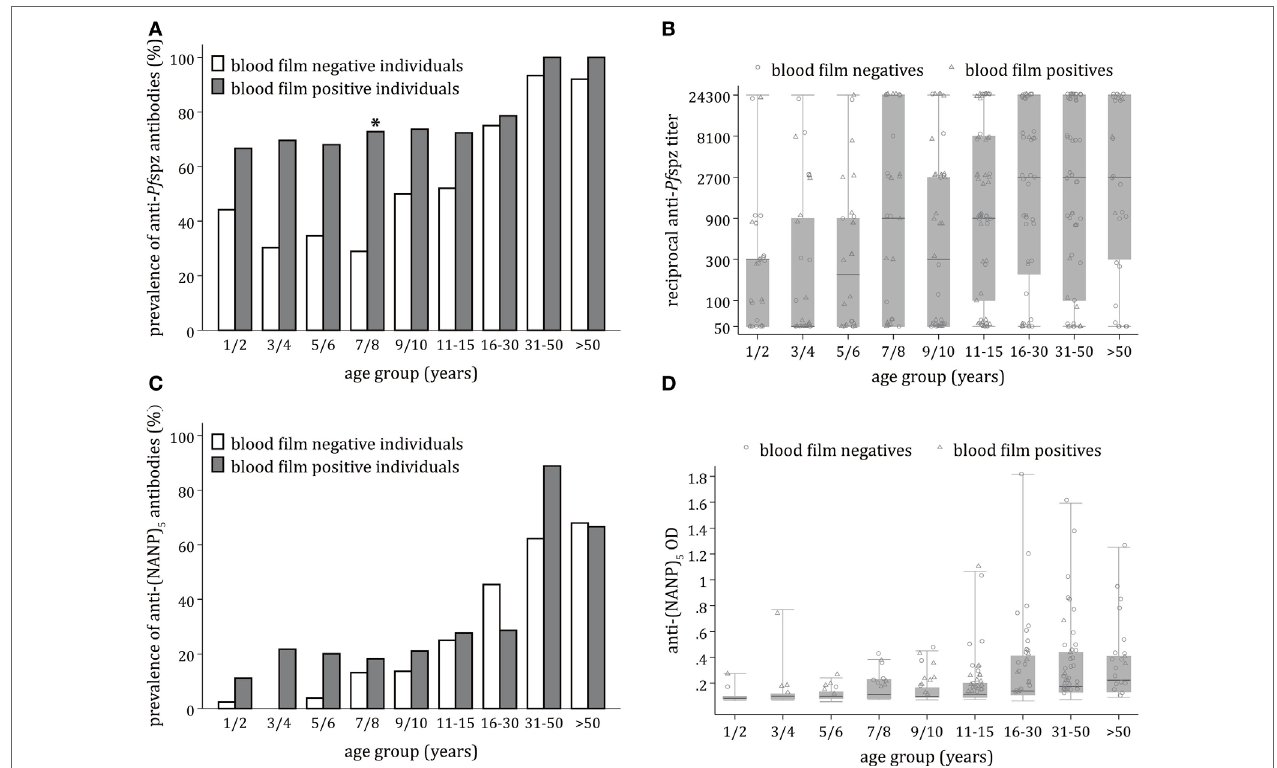
FigUre 2 | age-dependent acquisition of antisporozoite antibodies and correlation with microscopically detectable Plasmodium falciparum (Pf) infection . (a) Proportion of sera responding to Pf spzorozoites ( Pf spz) by immunofluorescence assay (IFA) in each age group, stratified by blood film